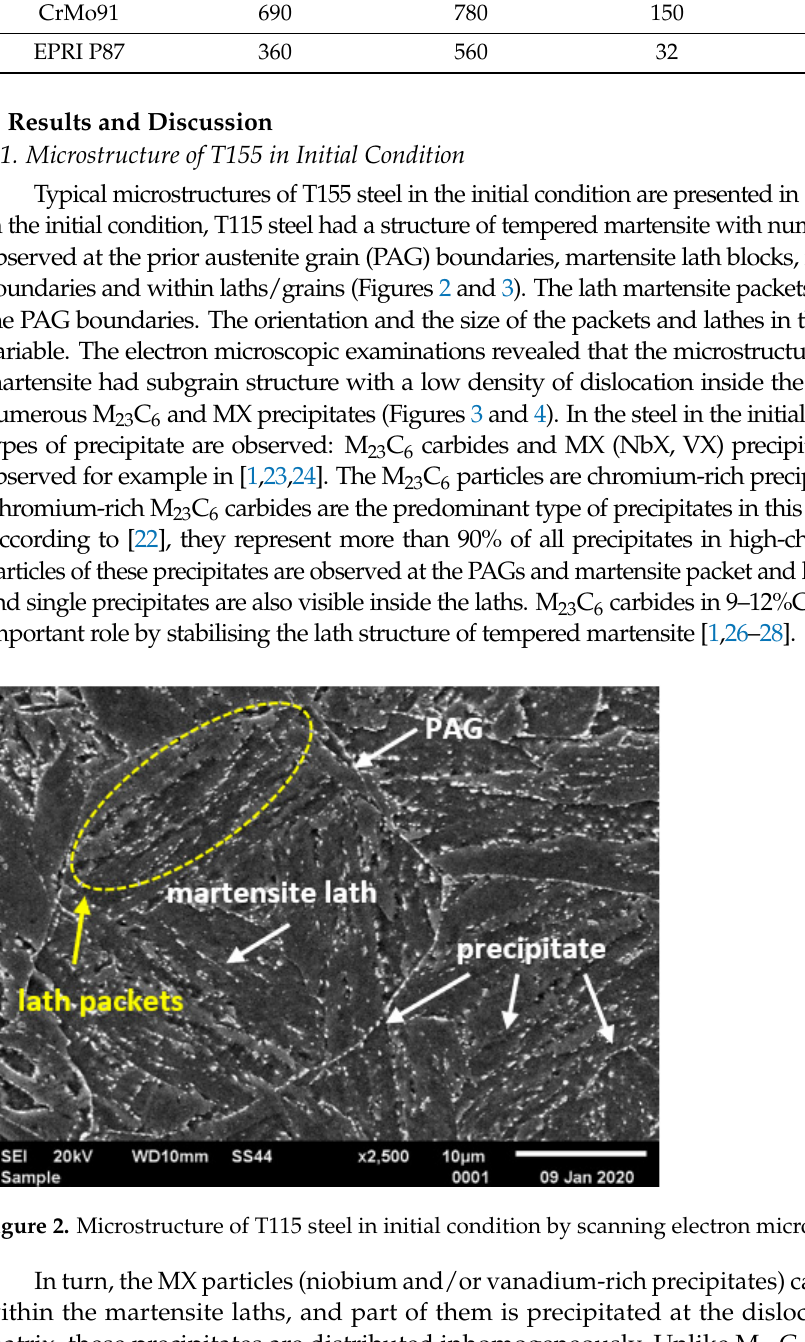
Table 4. Mechanical properties of CrMo91 and EPRI P87 filler materials.